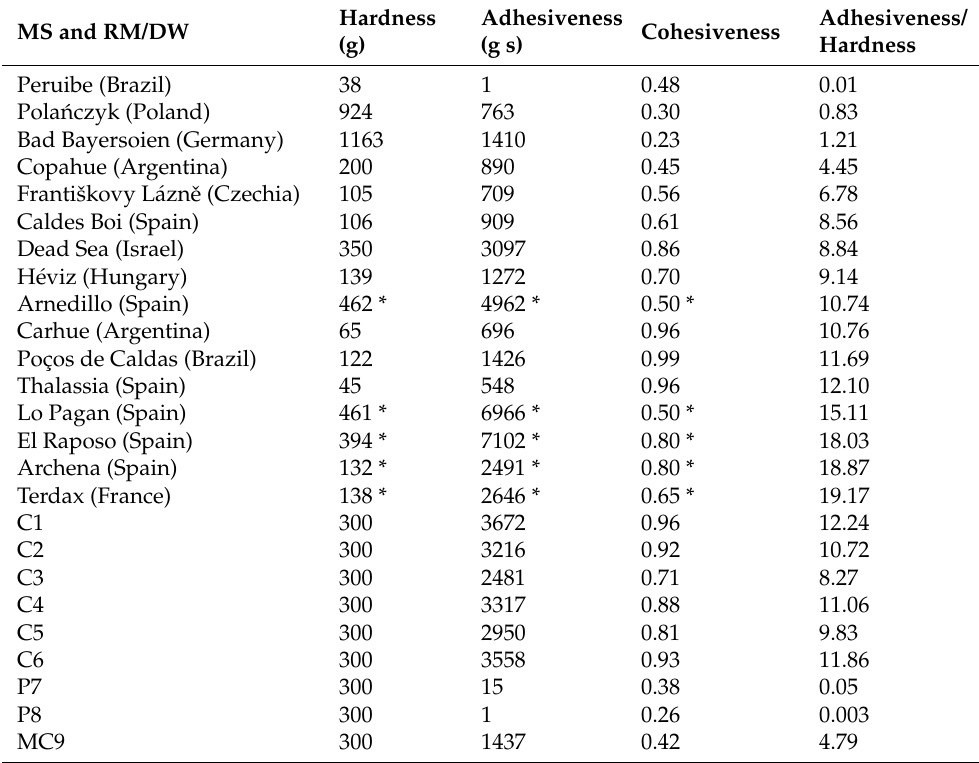
Table 3. Instrumental texture of the peloids used in medical spas (MSs) and the raw material–distilled water mixtures